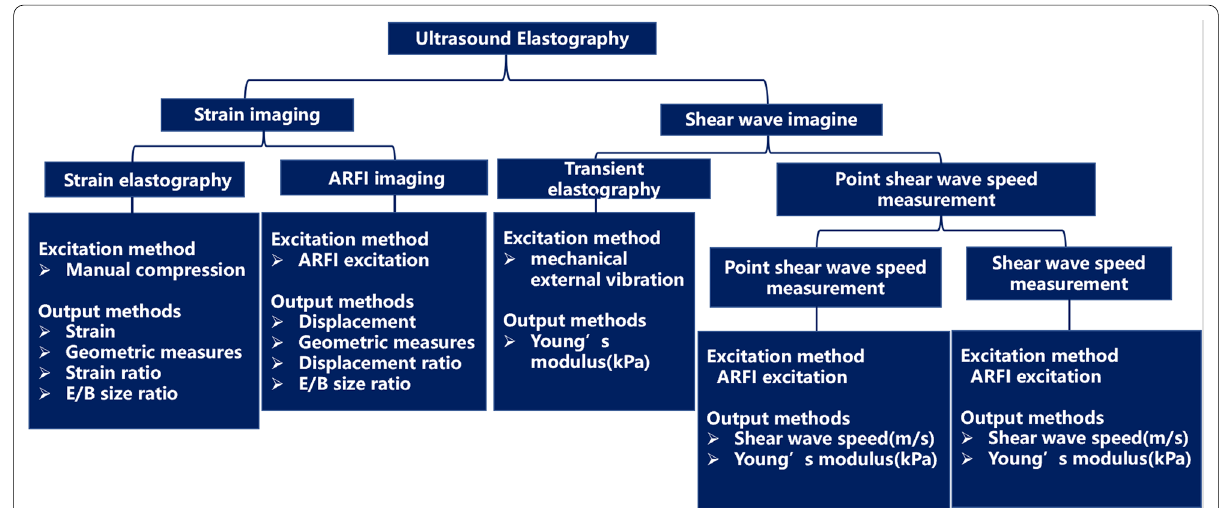
Fig. 3 The excitation and output methods for different ultrasound elastography modalities. ARFI acoustic radiation force